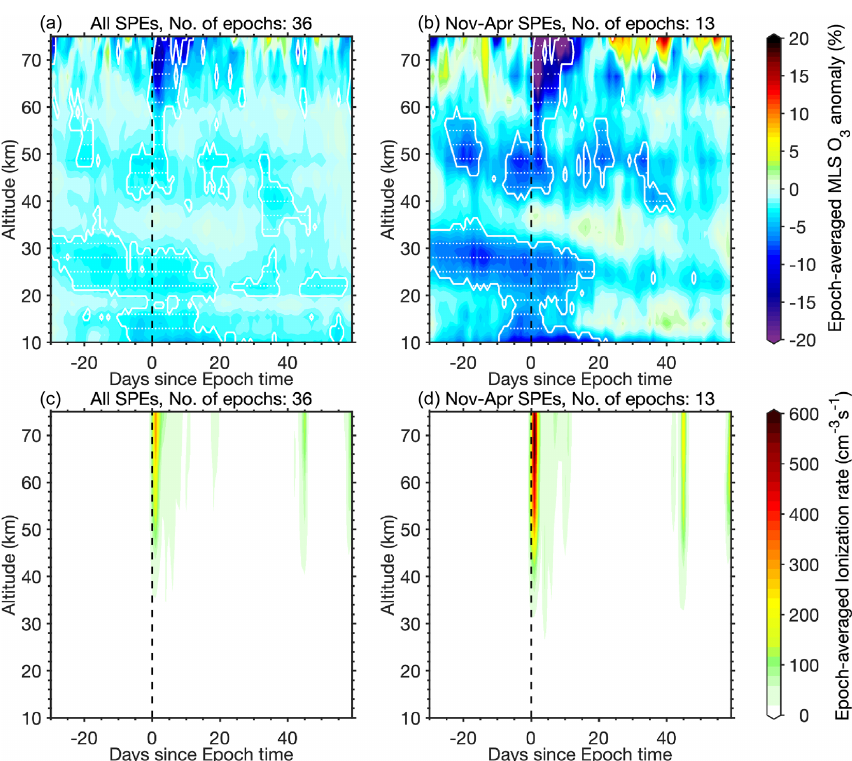
Figure 2. Epoch-averaged MLS ozone anomalies (relative in %) (a, b) and the corresponding daily ionization rates (c, d) in the northern polar region (60–90 ◦ N) along with geopotential altitude for a total of 35 isolated SPE epochs (a, c) and 13 isolated winter SPE epochs (b, d) . The black dashed line represents the epoch time, i.e., onset of SPEs. The white thick line area corresponds to the epoch-averaged anomalies with > 95% confidence after the Monte Carlo